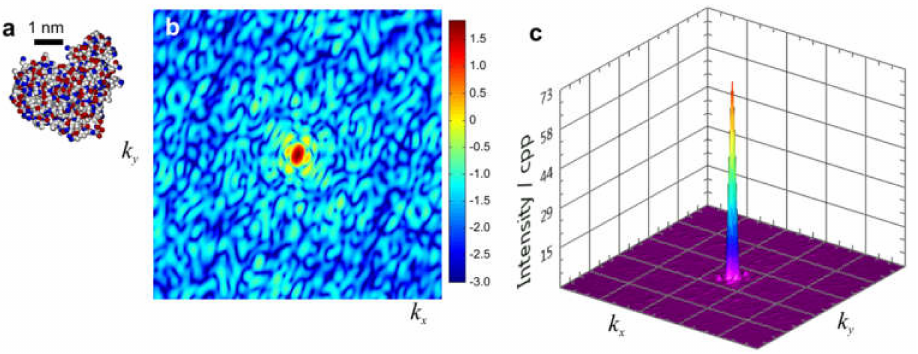
Figure 30. Simulated electron di ff raction pattern of a single lysozyme molecule. ( a ) Structure of the lysozyme molecule. ( b , c ) simulated di ff raction pattern with a radiation dose of 20 electrons per Å 2 in 2D and 3D representations, respectively; here k x and k y range from − 0.5 Å − 1 to 0.5 Å − 1 , corresponding to a resolution at the rim of the di ff raction pattern of 2 Å. The maximum of intensity is 73 cpp. Di ff raction pattern (DP) in ( b ) is shown as log 10